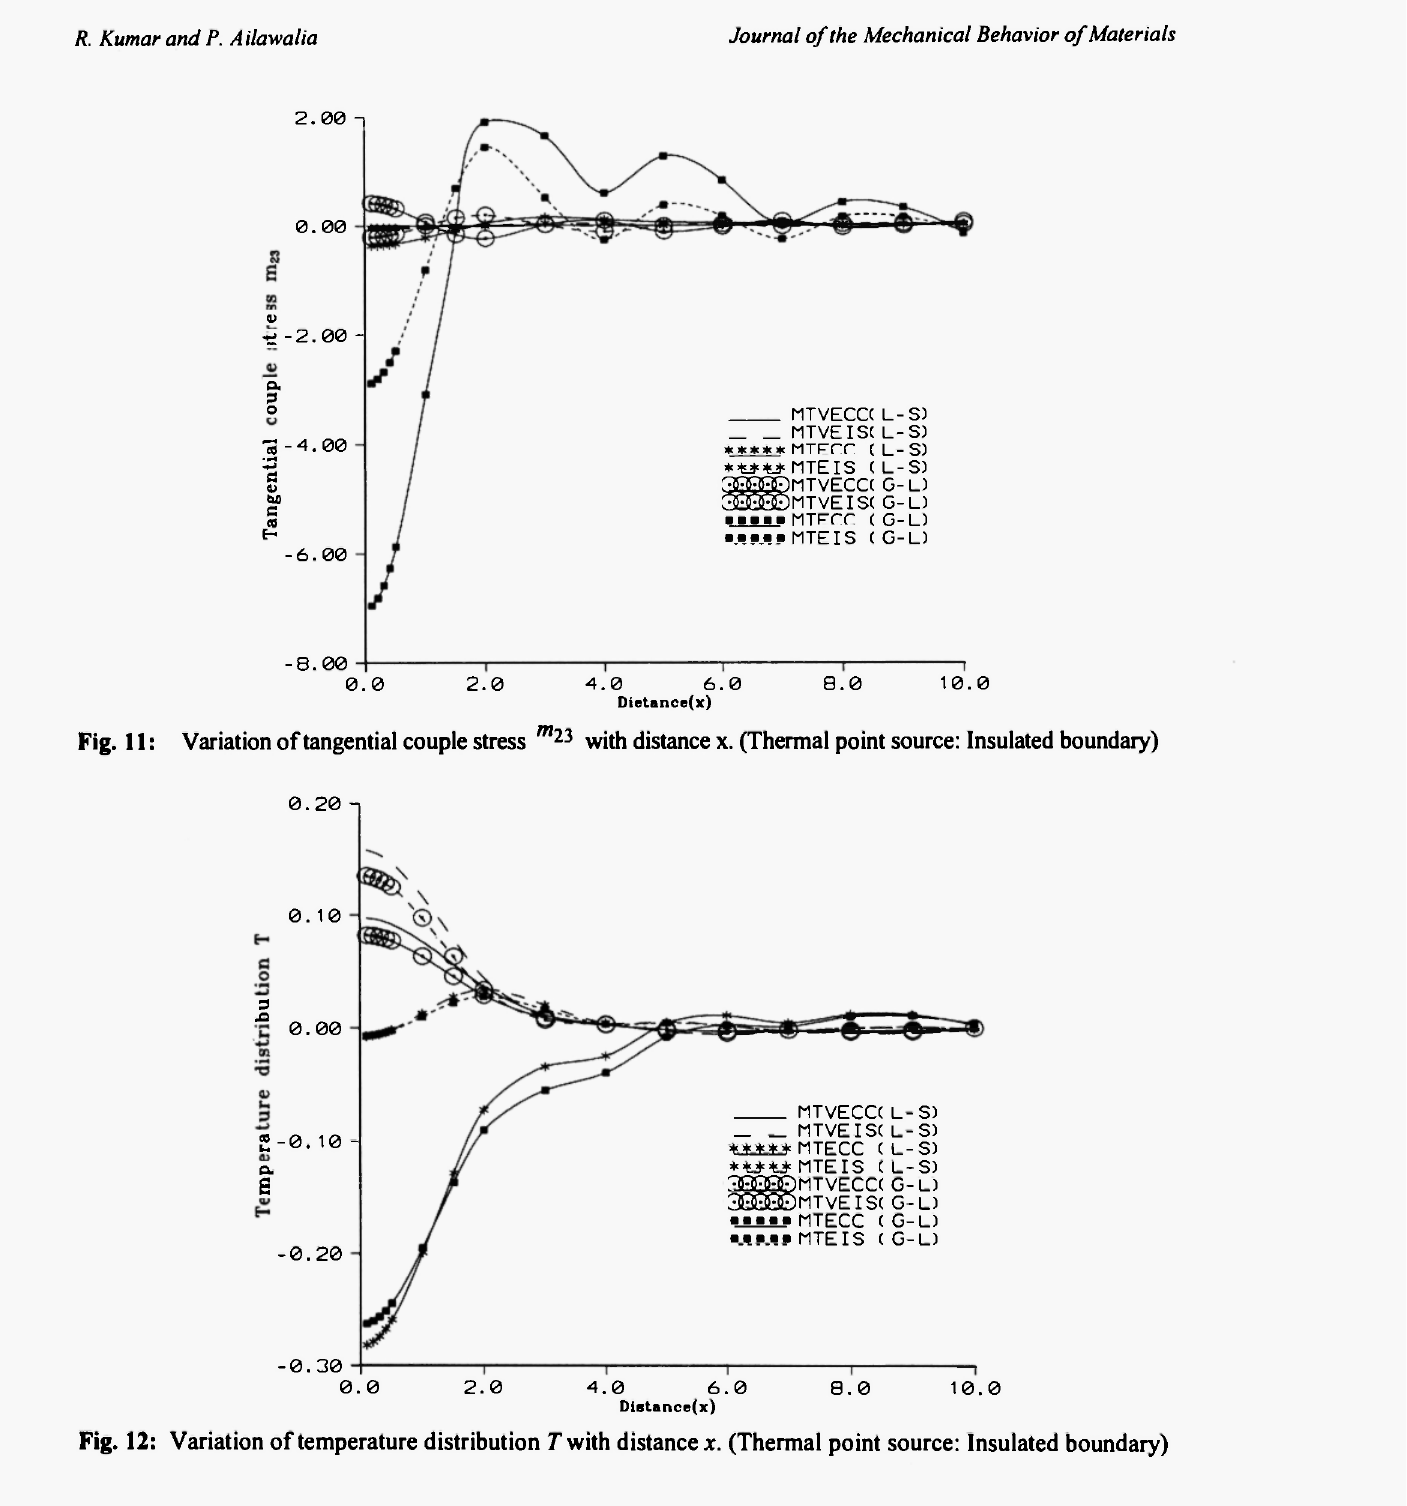
Fig. 12: Variation of temperature distribution Τ with distance x. (Thermal point source: Insulated